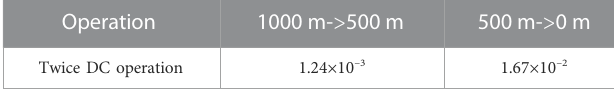
TABLE 4 MSE of errors of repeated DC